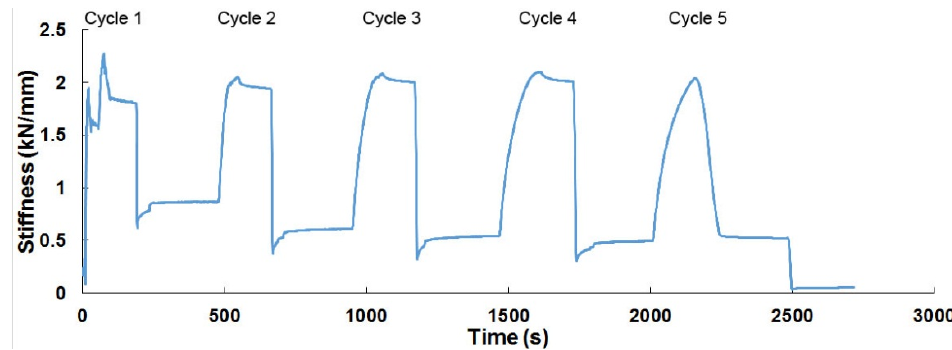
Figure 9 . Stiffness degradation of the notched beam.